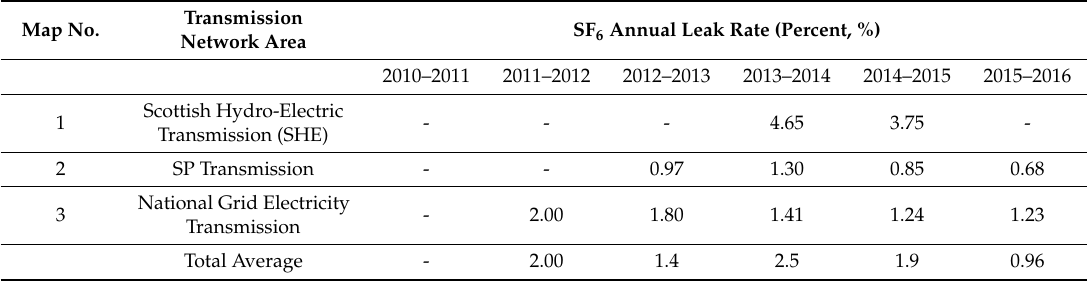
Table 10. Estimated SF 6 Annual leak rate on the transmission network (percent, %) in Great Britain. Map